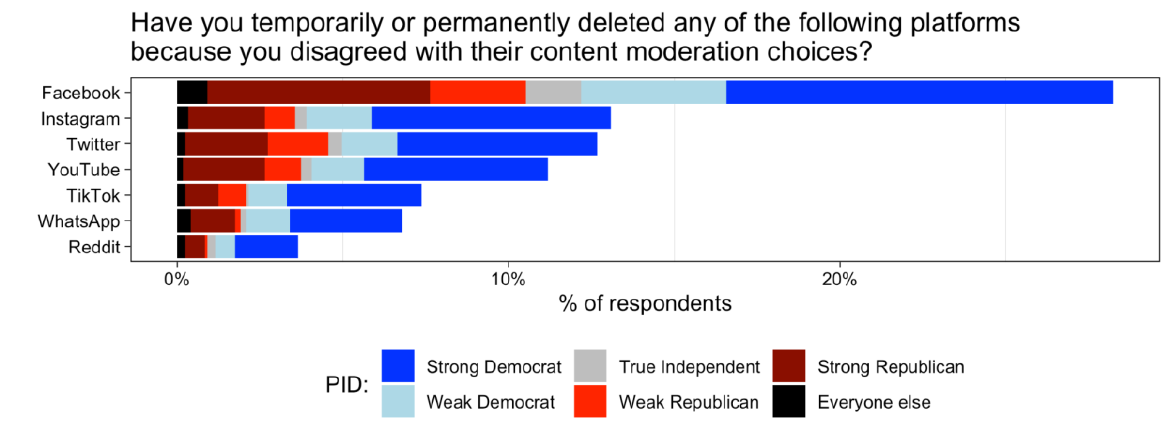
Figure 9. Self-reported rates of temporary or permanent platform deletion by